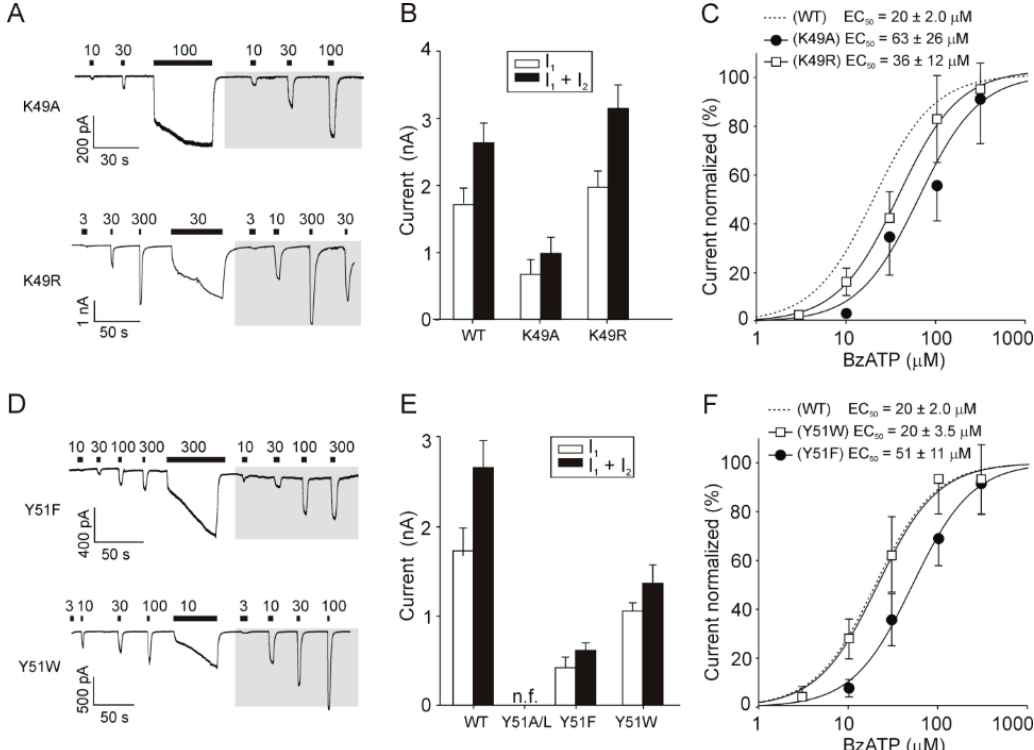
Figure 3. Rescue of receptor function by replacing K49 with an arginine and Y51 with an aromatic residue. ( A ) Example records of BzATP-induced responses mediated by the K49A and K49R receptors. ( B ) The amplitude of 300 µ M BzATP-induced initial (I 1 ) and maximum (I 1 + I 2 ) currents for the WT, K49A, and K49R receptors. ( C ) The concentration–response curves for WT (dotted curve), K49A, and K49R. ( D ) Example records of BzATP-induced responses mediated by the Y51F and Y51W receptors. ( E ) The amplitude of 300 µ M BzATP-induced initial (I 1 ) and maximum (I 1 + I 2 ) currents for the WT, Y51F, and Y51W receptors. The Y51A and Y51L mutations were nonfunctional (n.f.). ( F ) The concentration–response curves for the WT (dotted curve), Y51F, and Y51W evaluated after prolonged exposure to the agonist. The data are presented as the means ± SEMs of 5–35 cells per concentration, and the numbers represent the mean of EC 50 values after current facilitation.